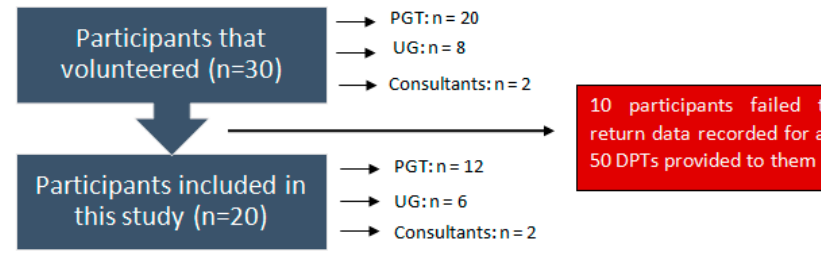
Figure 1. Flowchart of participants.